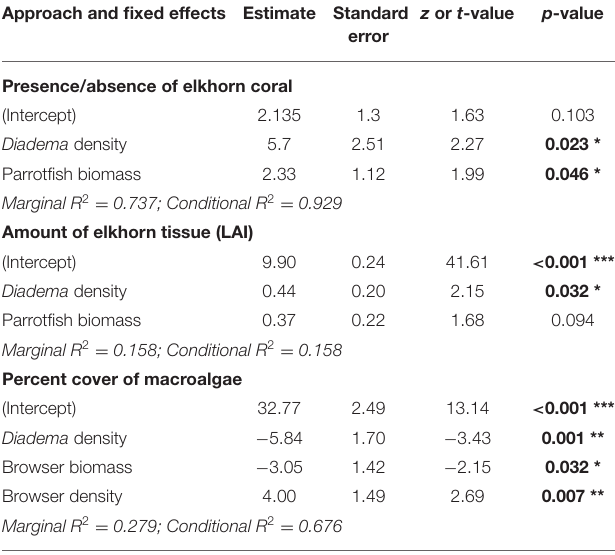
TABLE 3 | Estimated regression parameters, standard error, z -value or t -value, and p -values from the final linear mixed-effects models. Approach and fixed effects Estimate Standard